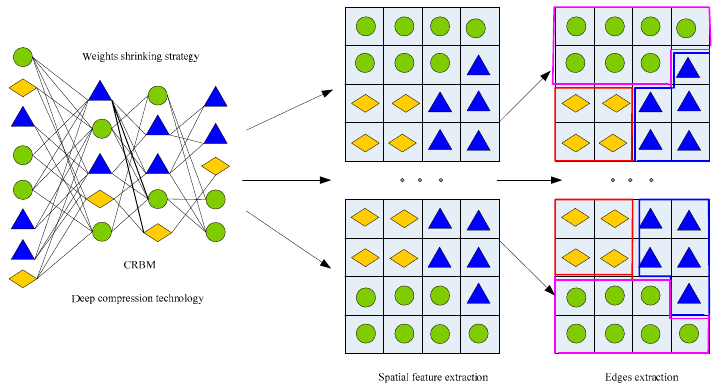
Figure 5. The processing framework of weights shrinking, spatial feature and edges extraction by d-CDBNs.